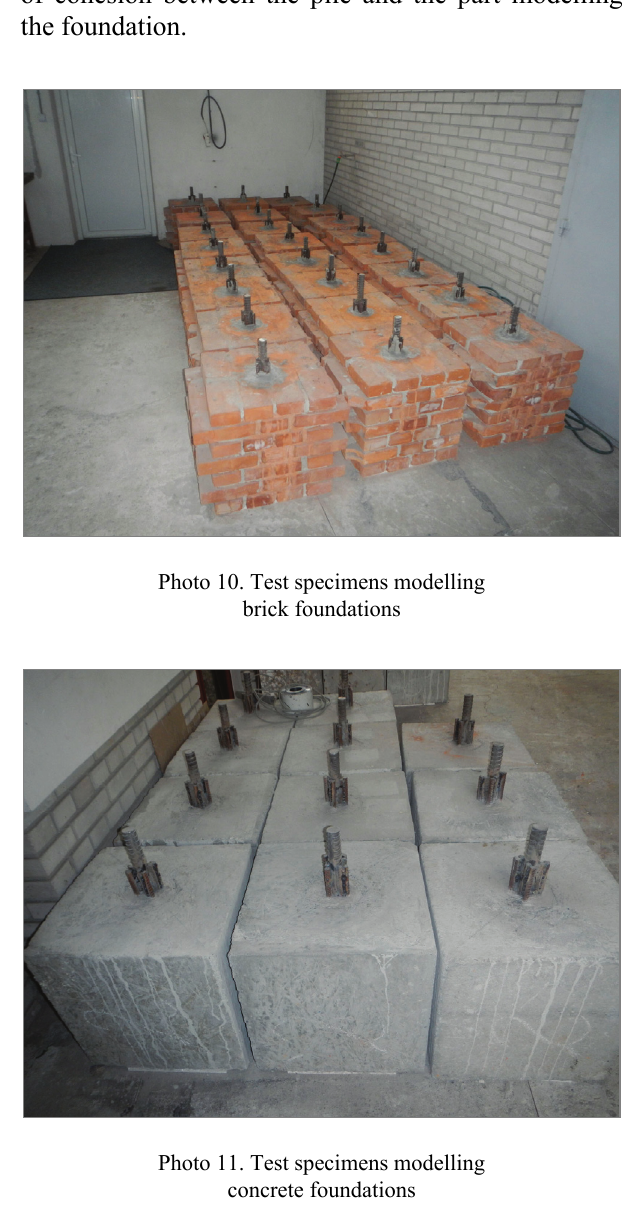
Fig. 16. Location of displacement